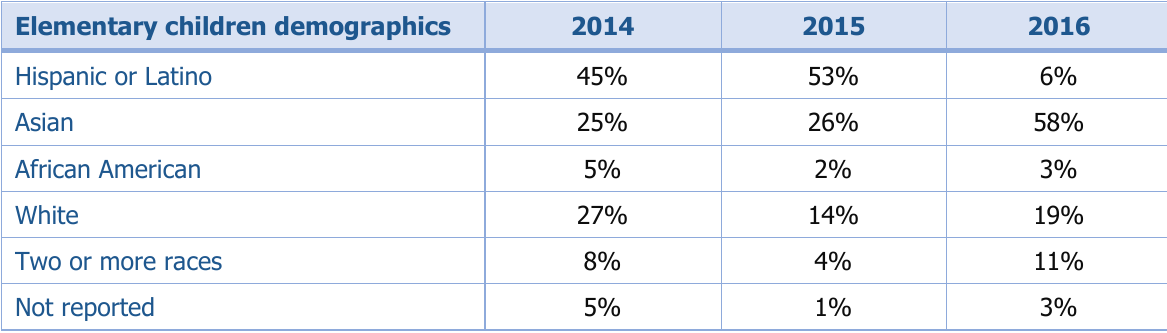
Table 4. Demographics for Elementary Children Participating in HLA